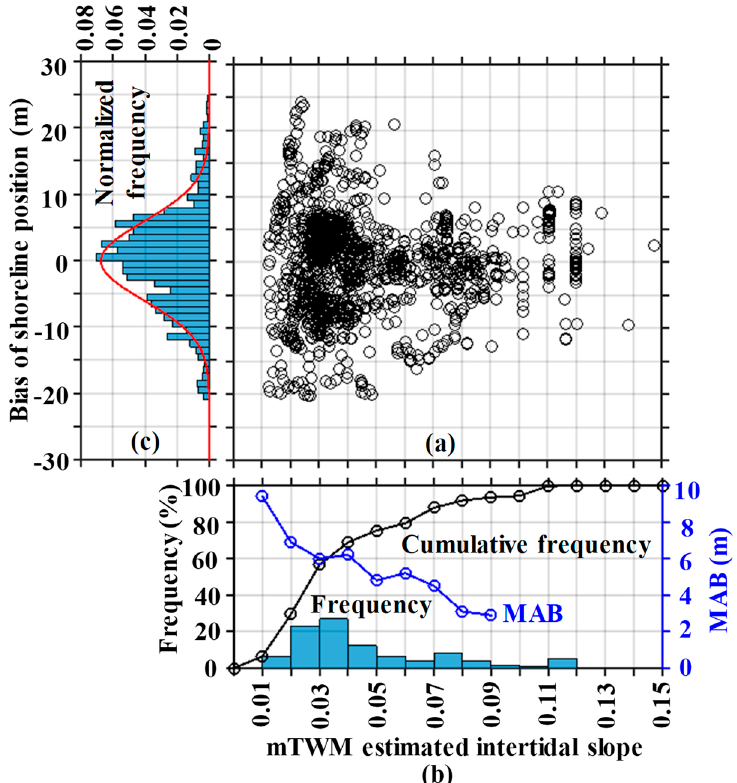
Figure 26. ( a ) The relationship between the mTWM-estimated slope and the estimated bias of shoreline positions. ( b ) The frequency distribution of mTWM-estimated slopes and the corresponding MAB estimation of shoreline positions. ( c ) The frequency distribution of estimated bias of shoreline positions.